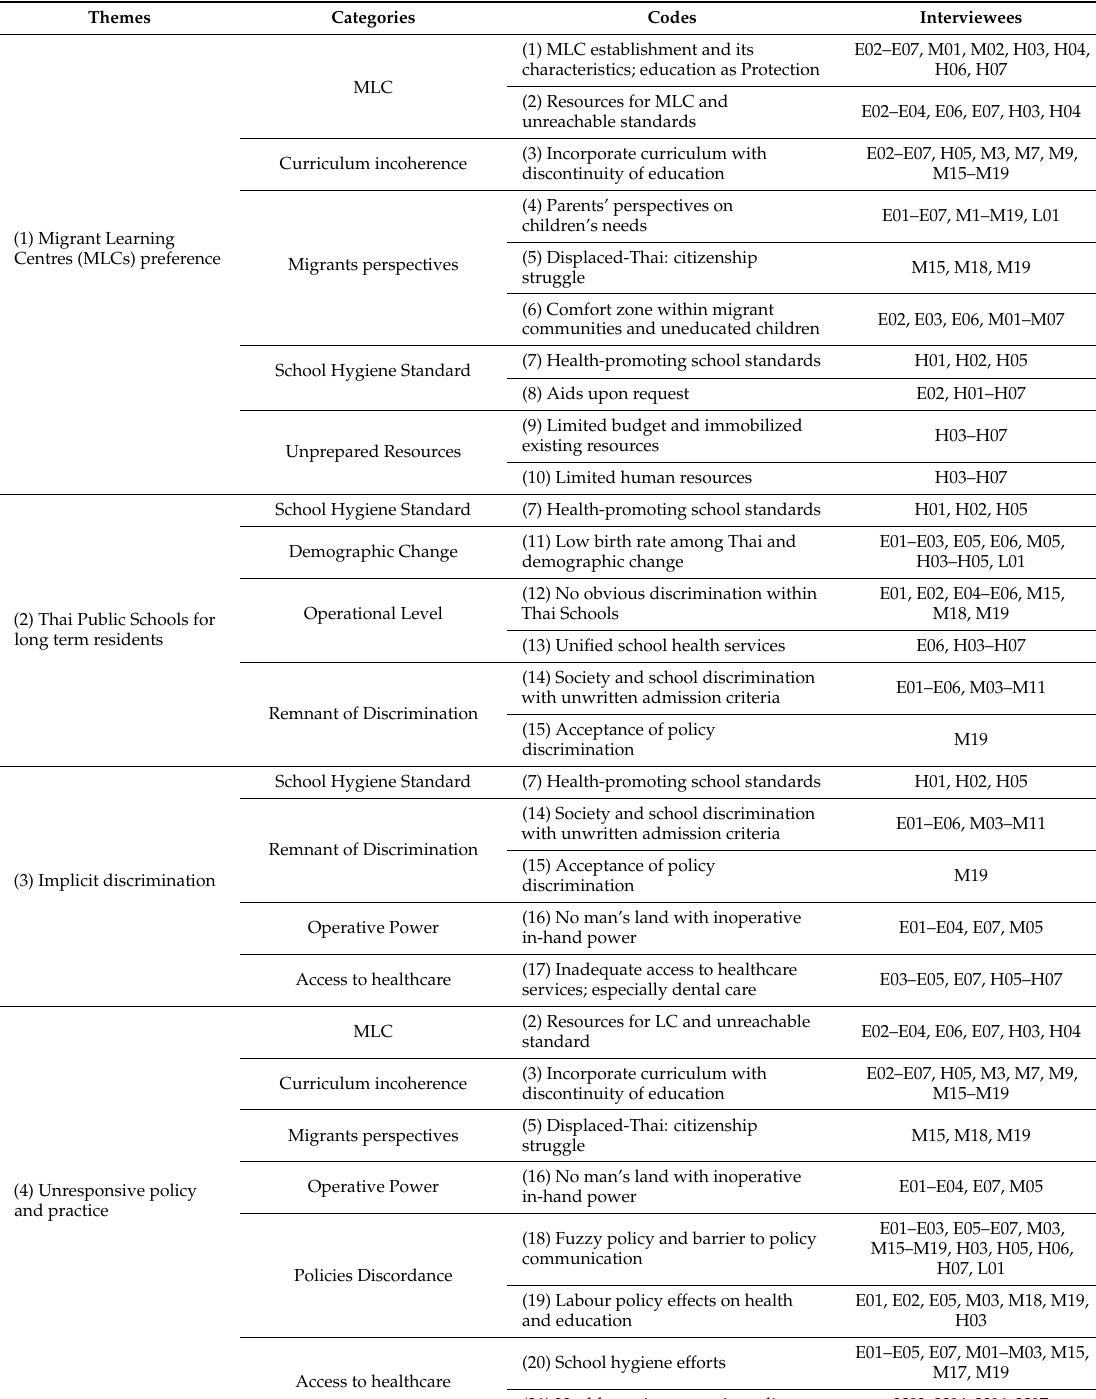
Table 3. Thematic analysis of the